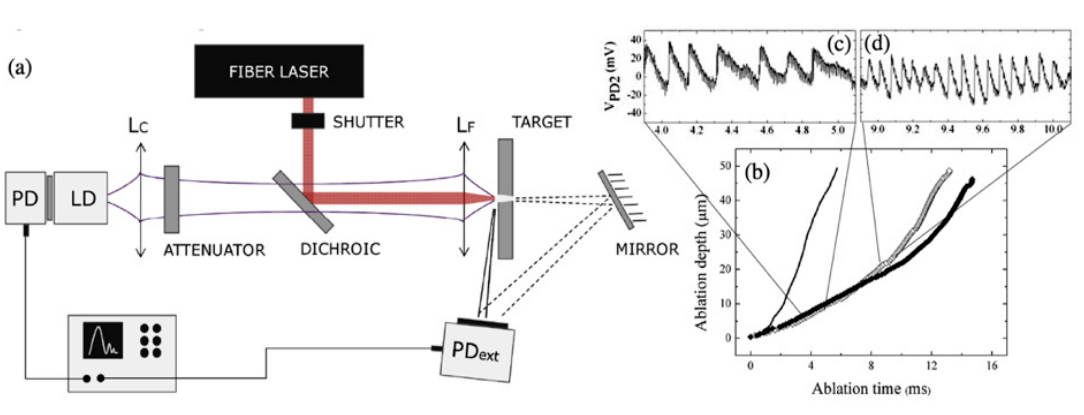
Figure 3. ( a ) Experimental setup of the OF ablation sensor. ( b ) Reconstructed ablation front progression from analysis of OF signal. ( c , d ) Representative OF fringes at different ablation rates (adapted from Reference [31]).